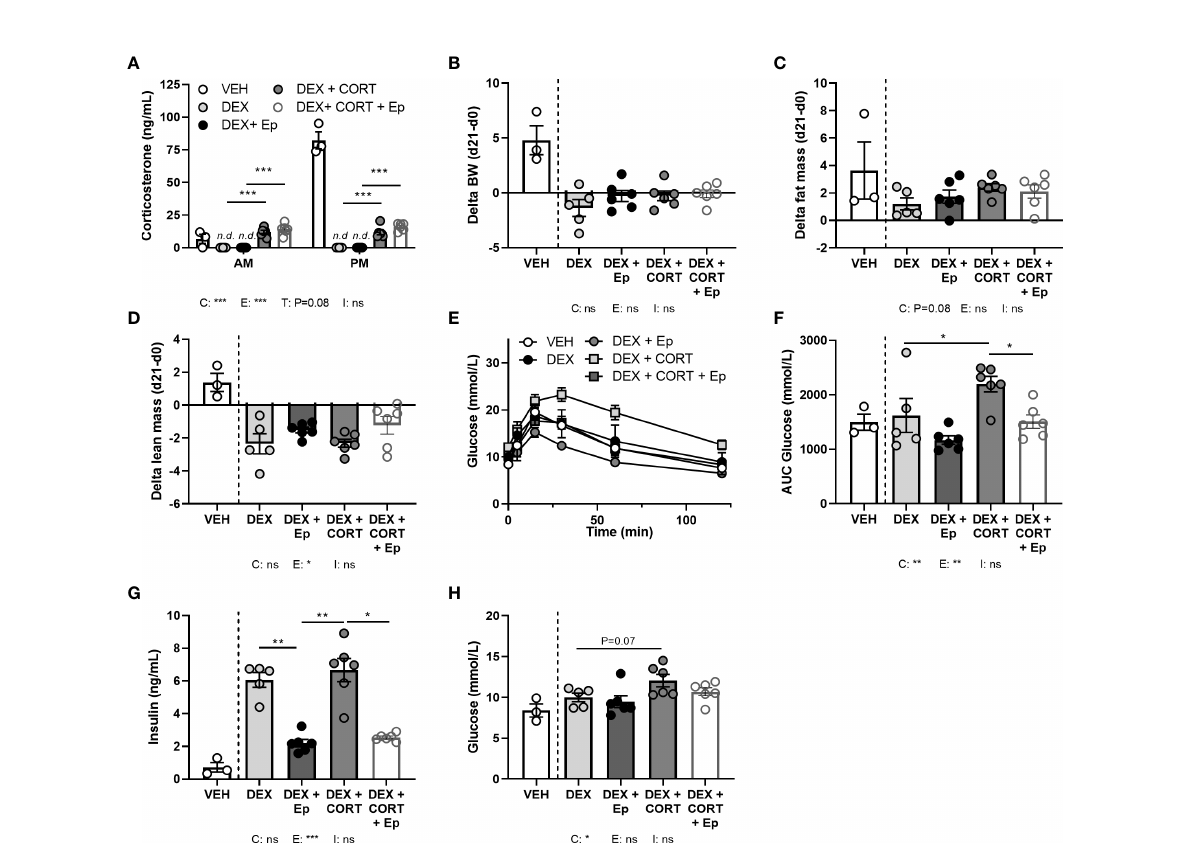
FIGURE 8 Eplerenone reduces the glucose intolerance and hyperinsulinemia caused by corticosterone add-on. Mice received a high-fat diet mixed with vehicle (VEH), dexamethasone (DEX) with or without eplerenone (Ep) and were subcutaneously implanted with corticosterone (CORT) or vehicle pellets for 3.5 weeks. (A) After Ep, plasma CORT levels were unaltered at AM (ZT1) and PM (ZT11) of the light phase at day 21. (B – D) Comparing gains per mouse (delta), Ep did not in fl uence body weight or fat mass, but decreased lean mass. (E, F) DEX+CORT exacerbated oral glucose intolerance compared to DEX at ZT1 at day 10, which was prevented by Ep. (G, H) Ep reduced insulin levels, but not glucose levels. The vehicle group was excluded from statistical analyses. Statistical signi fi cance was calculated using 2-way ANOVA analysis in (B – D and F – H) and with 3- way analysis in (A) . Depicted below the graphs are the P-values of the ANOVA tests for either CORT (C), Ep (E) or the interaction between CORT and Ep (I). *P < 0.05, ** P < 0.01, ***P < 0.001. ‘ ns ’ means ‘ not signi fi cant ’